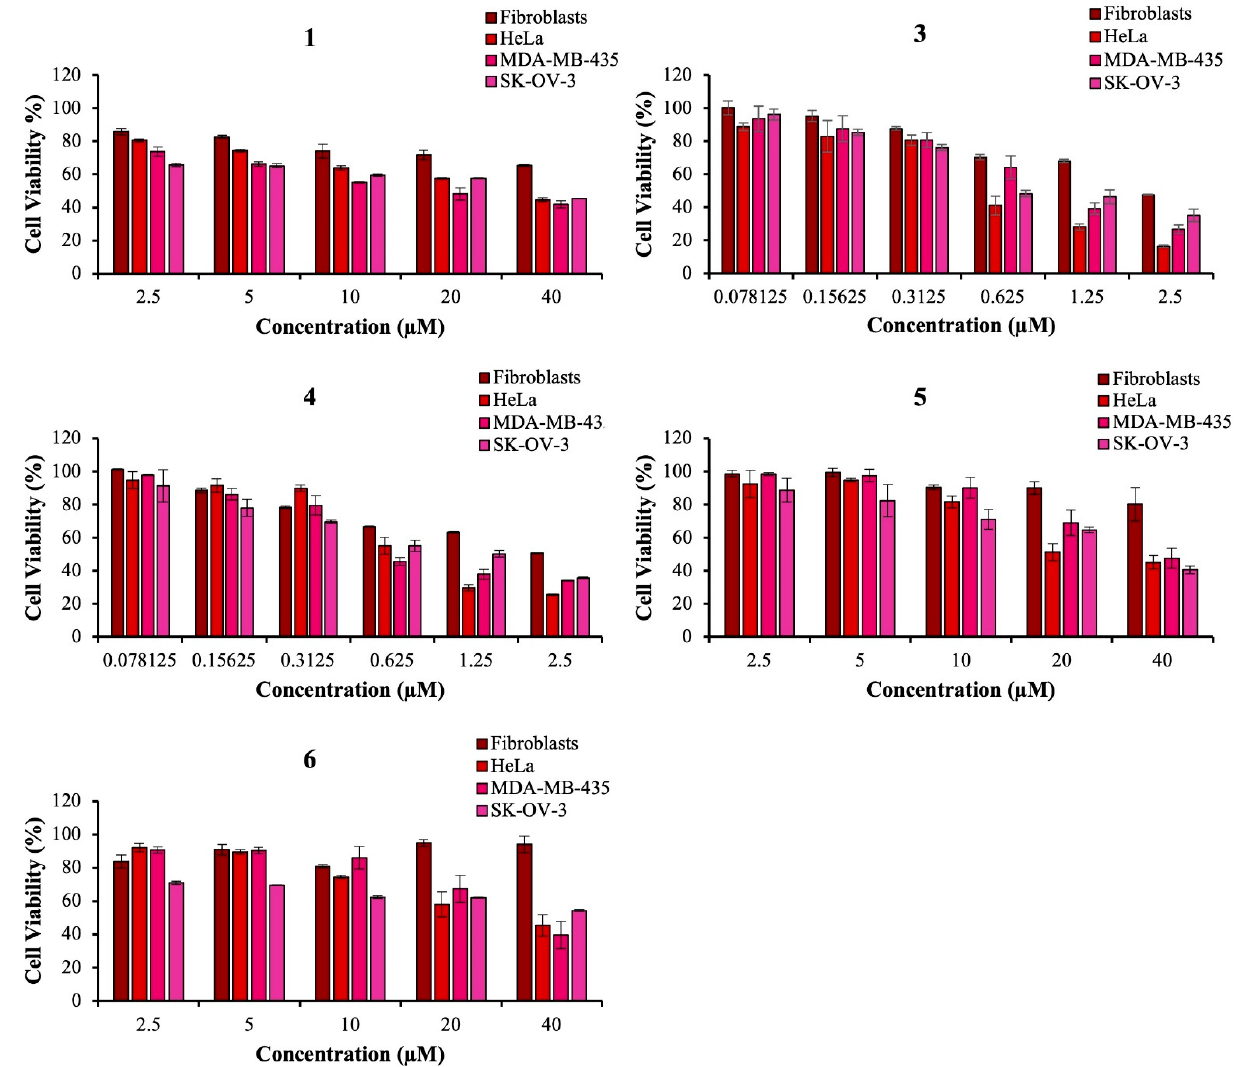
Figure 7. The effect of compounds 1 , 3 , 4 , 5 and 6 on different types of cancer cell lines and fibroblasts viability. HeLa, MDA-MB-435S and SK-OV-3 cell lines and fibroblasts were treated with indicated concentrations of analyzed compounds. The cell survival was measured 72 h after the treatment by MTT assay. The experiments were done in quadruplicate and repeated at least three times.